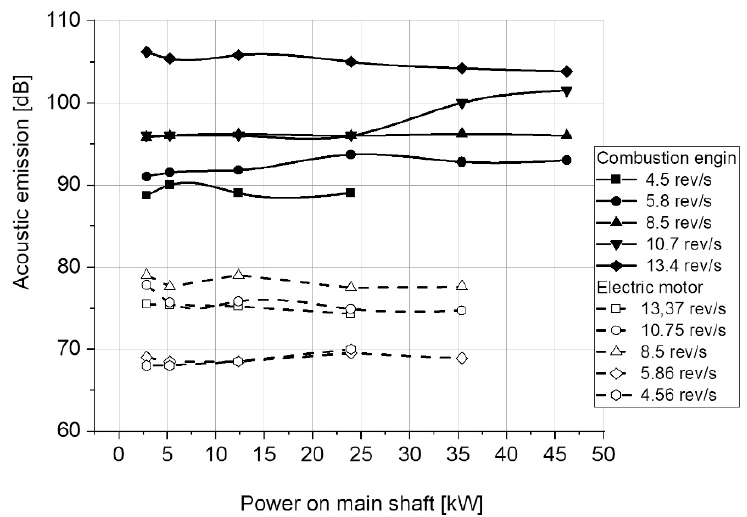
Figure 9. Results of acoustic emission measurements for the analysed operating points of the hybrid propulsion in the electric and combustion engine operation mode.